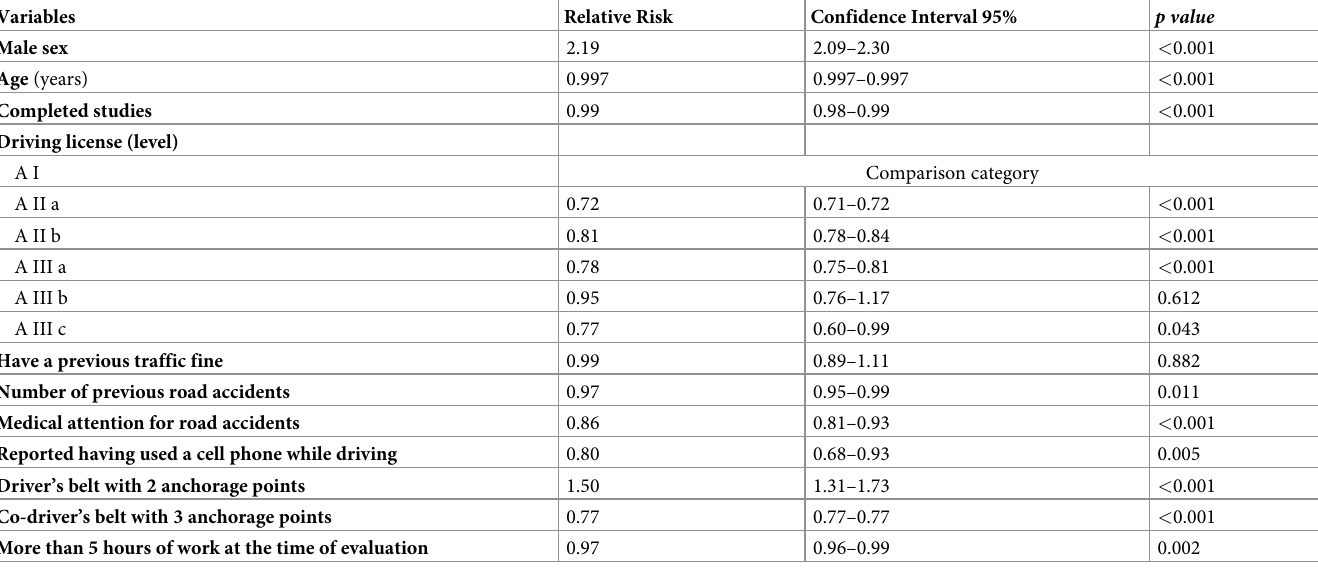
Table 4. Multivariate analysis of risk factors associated with seat belt use among public transport drivers in Tacna-Peru.